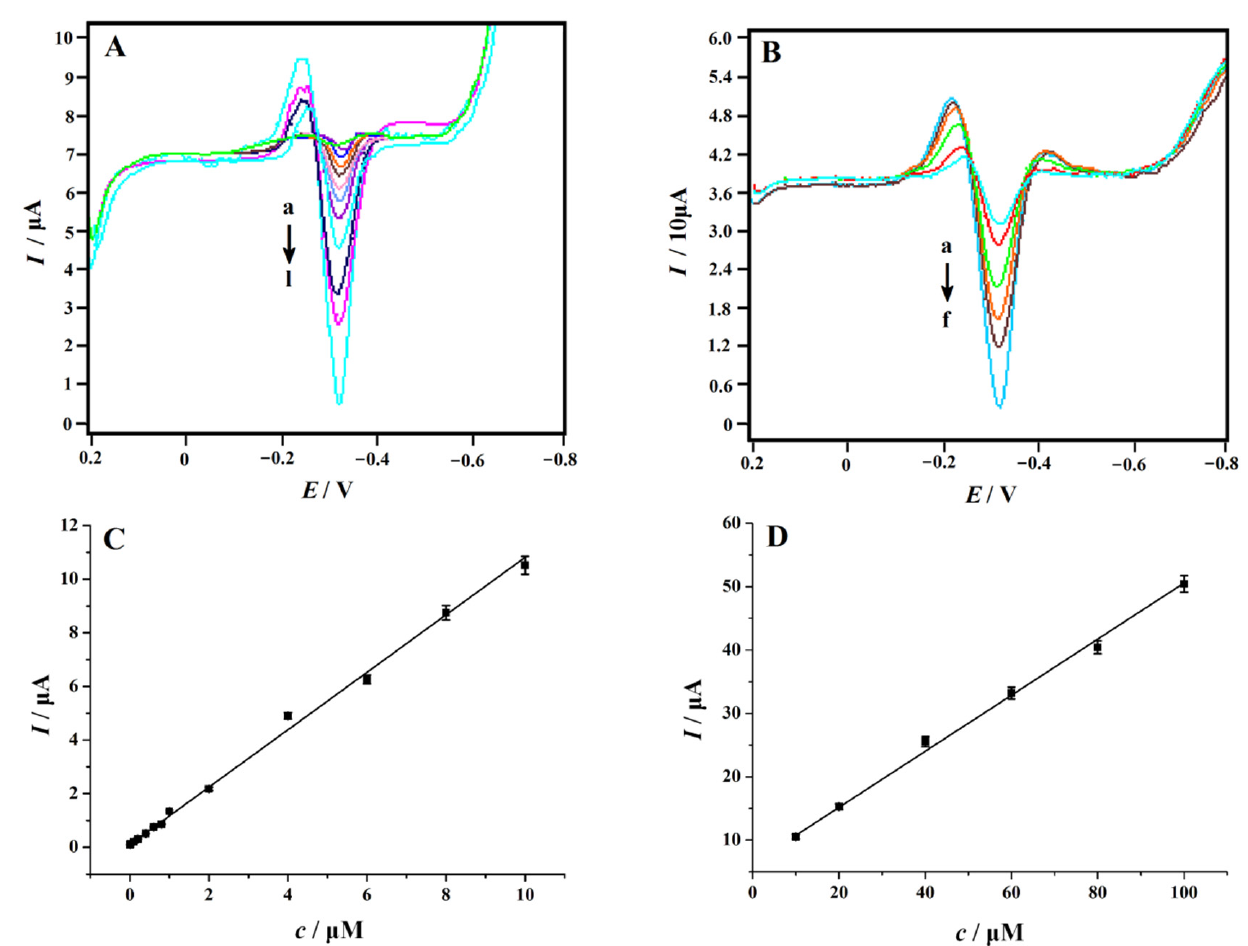
Figure 8. Second-order derivative linear sweep voltammograms of different concentrations of 4-NP recorded on the NC–PEI/GCE after accumulating at 0.2 V for 150 s. ( A ) Form a to l: 0.06, 0.08, 0.1, 0.2, 0.4, 0.6, 0.8, 1.0, 2.0, 4.0, 6.0, 8.0 and 10 µ M 4-NP; ( B ) Form a to f: 10, 20, 40, 60, 80 and 100 µ M 4-NP; ( C ) plots of the peak currents versus 4-NP concentrations in the range of 0.06–10 µ M; and ( D ) plots of the peak currents versus 4-NP concentrations in the range of 10–100 µ M, error bars represent SD, n = 3.